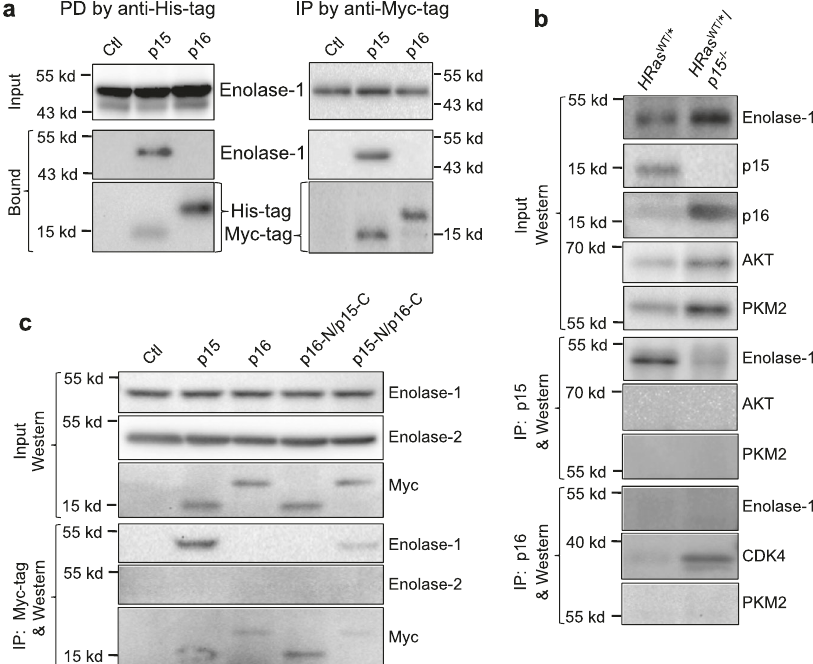
Fig. 7 p15, but not p16, binds enolase-1 in vitro and in vivo. a (left panel) Protein pull-down (PD) using E. coli -expressed, histidine-tagged and nickel column-immobilized p15 or p16 in the presence of total proteins from parental UMUC3 cells, and ( a , right panel) immunoprecipitation (IP) of Myc-tagged p15 or p16, followed by western blotting. Note in both experiments the highly speci fi c interaction of p15, but not p16, with enolase-1 with a molecular weight of 48-kDa. The side bars in the top two western blotting strips in the right panel denote molecular weight standards, 55-kDa (upper bar) and 43-kDa (lower bar). b p15 speci fi cally interacts with enolase- 1 in vivo. Total proteins were extracted from mouse urothelial cells expressing HRas* or those expressing HRas* and lacking p15, and were then subjected to immunoprecipitation followed by western blotting. One mouse per lane representative of a total of three independent mice per genotype. Note that enolase-1 was immunoprecipitated by anti-p15 antibody in p15-expressing, but not in p15-lacking urothelial cells (despite the fact that enolase-1 was signi fi cantly elevated in these cells); that p15 did not immune-precipitate AKT or PKM2; and that p16 did not immuno-precipitate enolase-1. c p15 binds, via its N terminus, to enolase-1. Myc-tagged, domain-switching mutants of p15 and p16 and wild-type controls were stably transfected and inducibly expressed in parental UMUC3 cells, and anti-Myc immunoprecipitation followed by western blotting was carried out. Note the speci fi c immunoprecipitation of enolase-1, but not enolase-2, by p15 and p15-N/p16C, but not by p16 or p16-N/p15-C. Experiments in a – c were repeated three times with similar results. Source data are provided as a Source Data fi